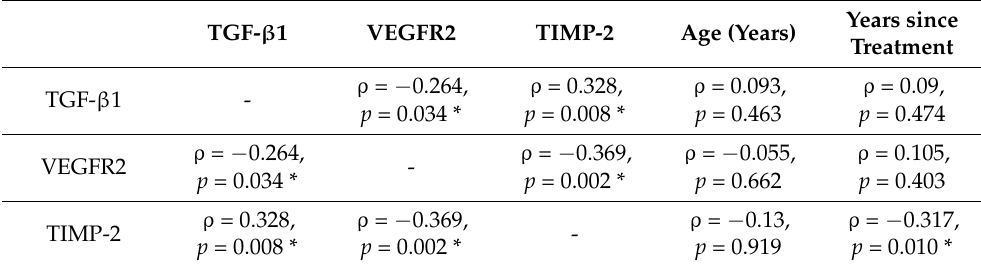
Table 8. Correlation analysis of the levels of fibrosis